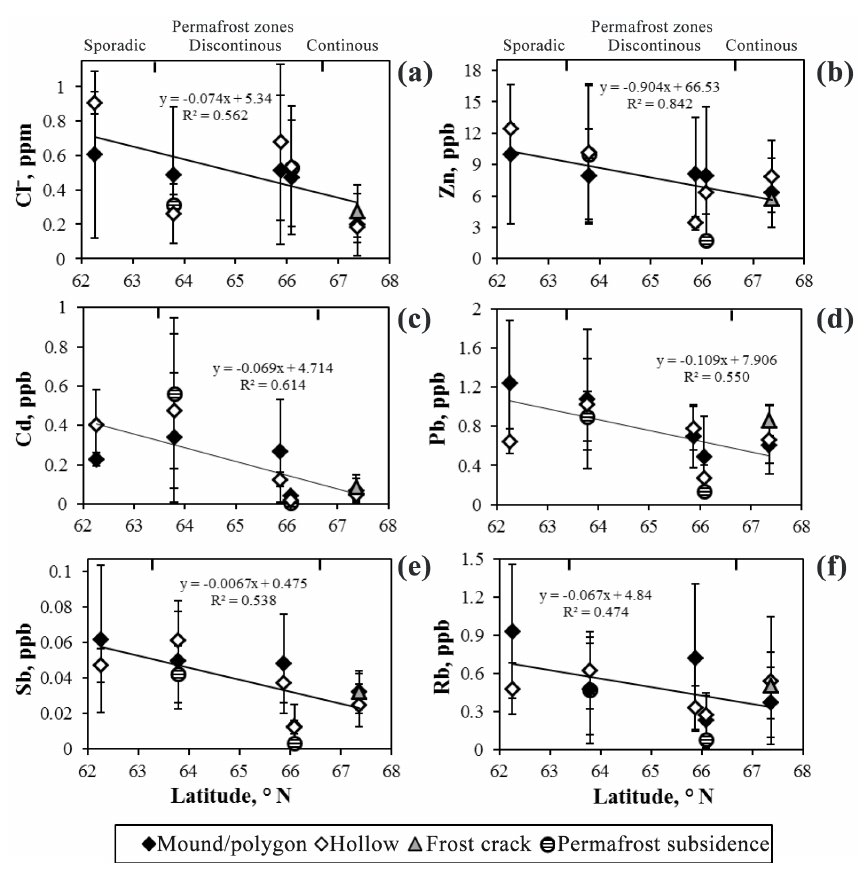
Figure 5. Mean concentrations of Cl (a) , Zn (b) , Cd (c) , Pb (d) , Sb (e) , and Rb (f) in peat porewaters of the WSL as a function of latitude for mound and polygons (solid diamonds), hollow (open diamonds), frost crack (grey triangles), and permafrost subsidence/depression (hatched circles). The solid line is a linear fit to all data with the regression equation given on each